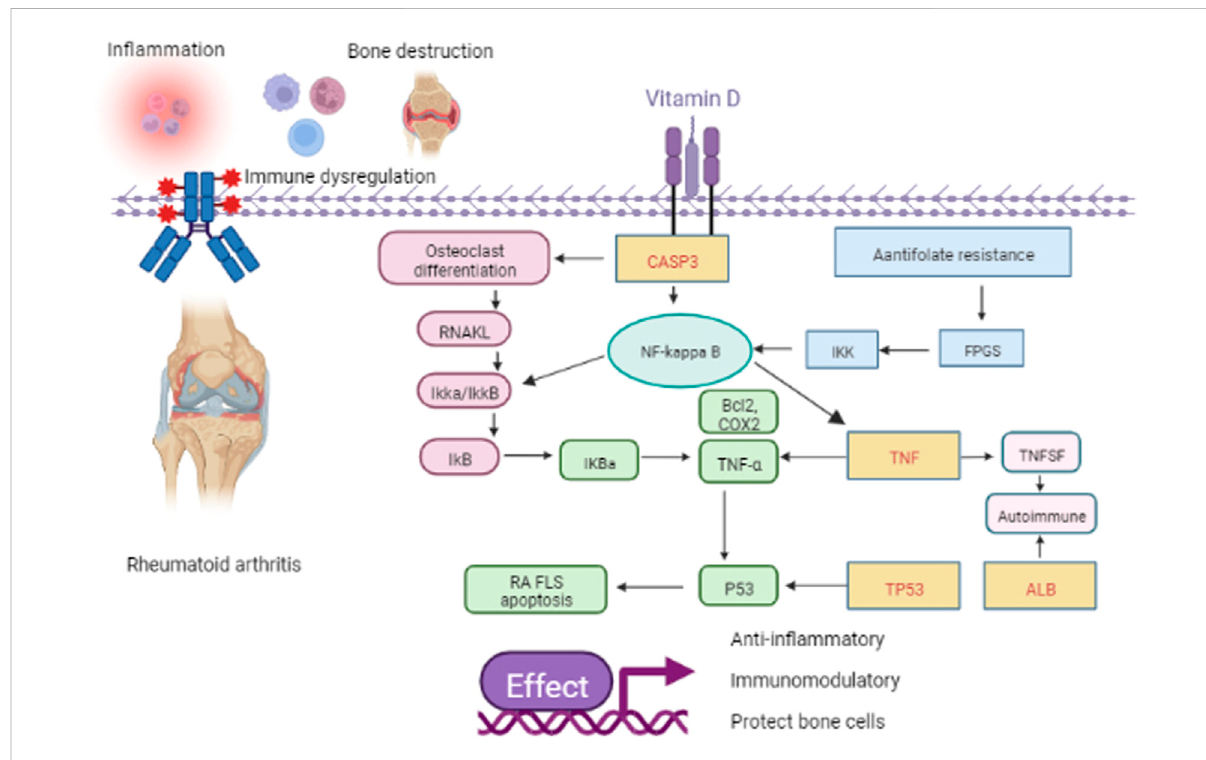
FIGURE 9 Schematic representation of the role of vitamin D in RA. The yellow rectangle with the red word represents the four key genes such as TP53, CASP3, TNF, and ALB. The pink rectangle, the blue rectangle, and the green circle represent the pathway of osteoclast differentiation, antifolate resistance, and NF-kappa B, respectively. Others represent the downstream